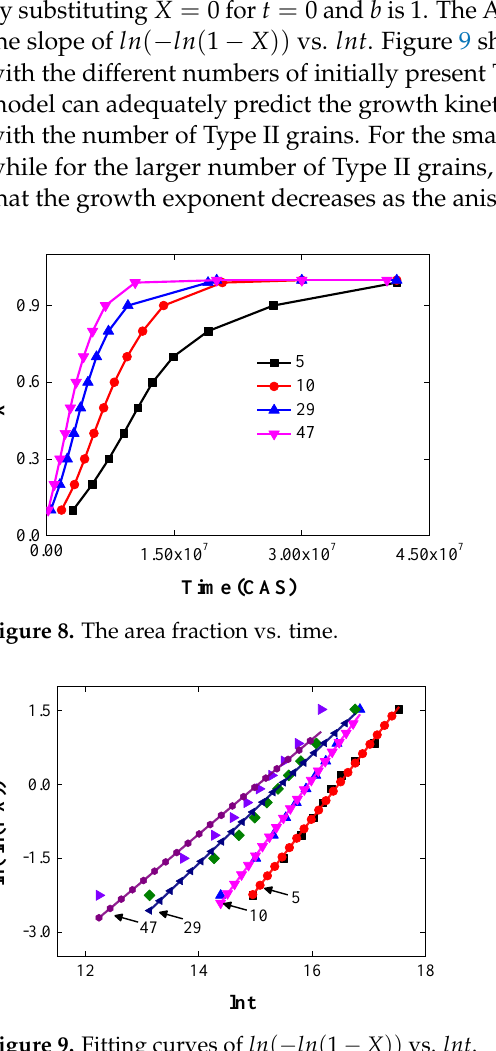
Figure 9. Fitting curves of ln ( − ln ( 1 − X )) vs. lnt .